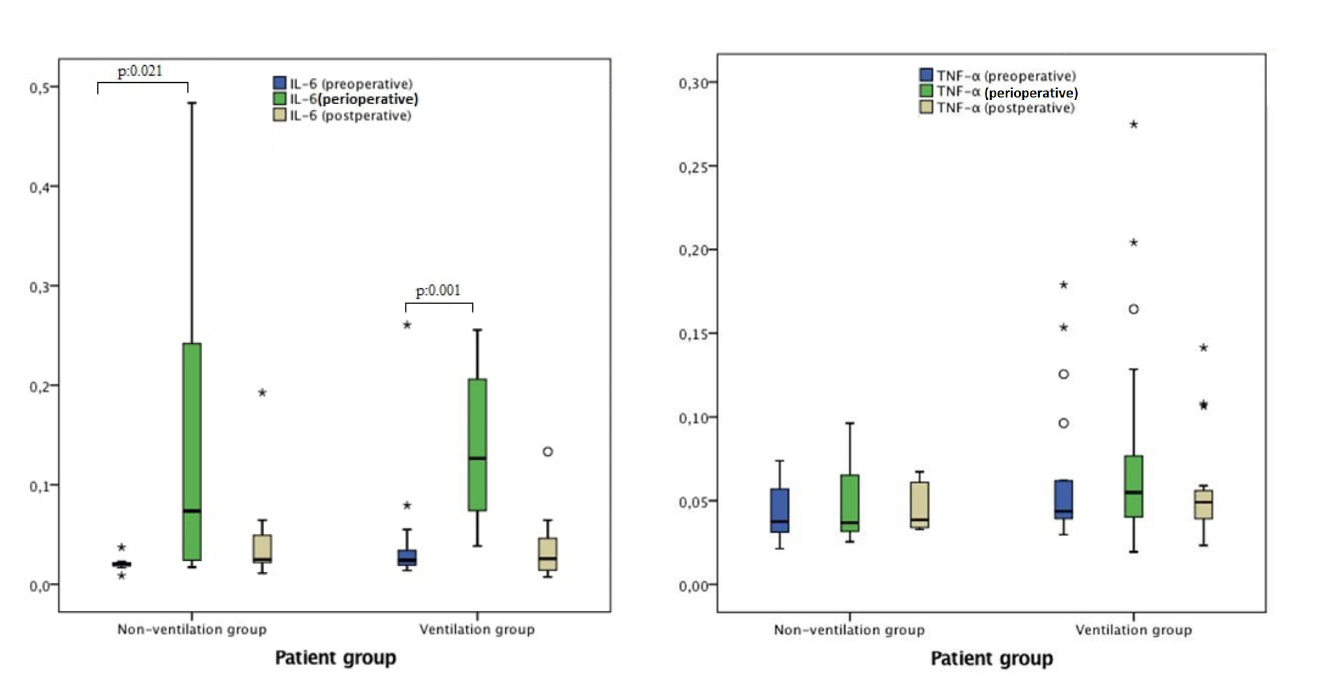
Fig. 2 - IL-6 measurements in preoperative (pre-CPB), perioperative (during CPB) and postoperative (post-CPB) periods.